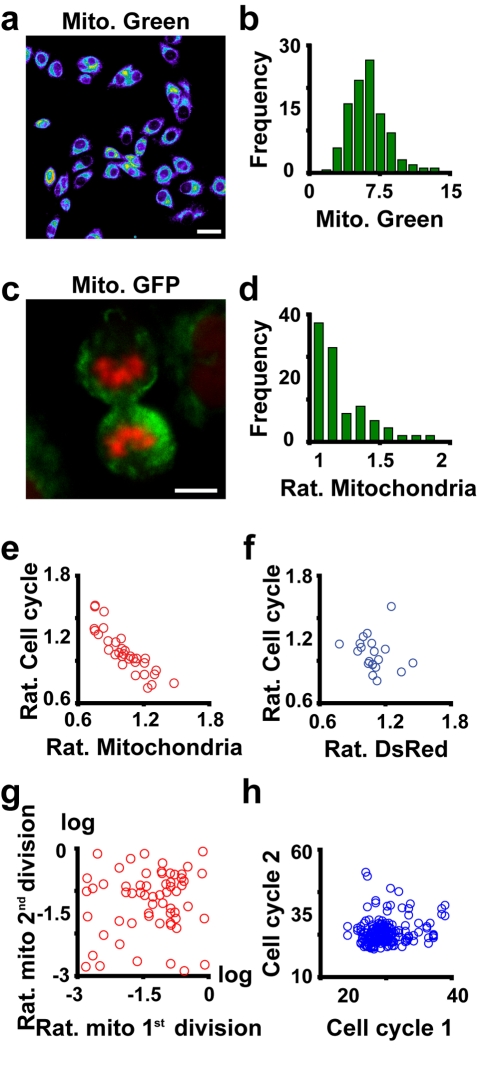
Asymmetric segregation of mitochondria.(A) Visualisation of mitochondria with MitoTracker Green FM. (B) Quantitative analysis of the mitochondrial content in samples stained as in (A) (n = 800). (C) Asymmetric segregation of mitochondria in mitotic cells. Cells in telophase show asymmetric segregation of mitochondria (green) and DNA (red). (D) Quantitative analysis of the ratio (rat.) of mitochondrial content between daughter cells (n = 300). (E) Mitochondrial content is correlated with the cell cycle length, as demonstrated by the plot of the ratio of cell cycle length versus the ratio of mitochondrial content between daughter cells at division (R
2 = 0.8). (F) A weak correlation was found between the ratio of daughter cell volumes at birth (measured by the soluble protein DsRed) and their relative cell cycle lengths (R
2 = 0.06). (G) Analysis of the difference in mitochondrial content between sister cells after the first division (ratio of intensities of mito-YFP) and the second division. No relationship could be observed between segregation of mitochondria in two consecutive mitotic events. (H) Analysis of the interdivision time between consecutive cell cycles in individual cells. Bars: (A), 10 µm; (C), 5 µm.